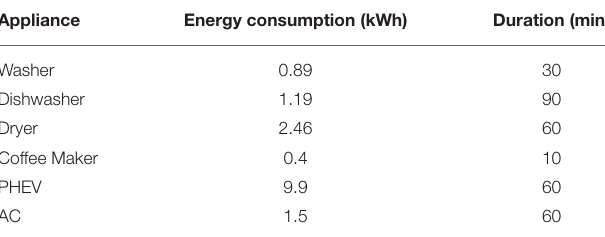
TABLE 4 | Energy consumption and cycle durations (Erol-Kantarci and Mouftah, 2010a,